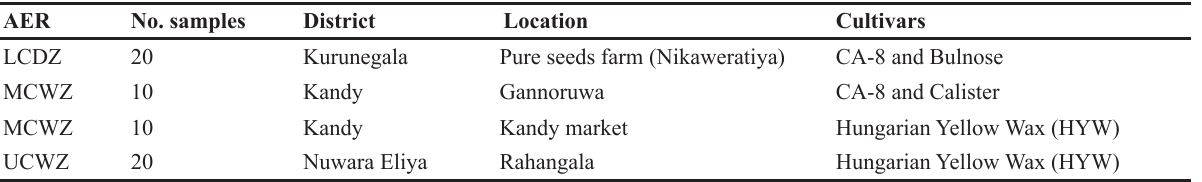
Table 1: Capsicum fruits collected from different cultivars from different locations. AER No. samples District